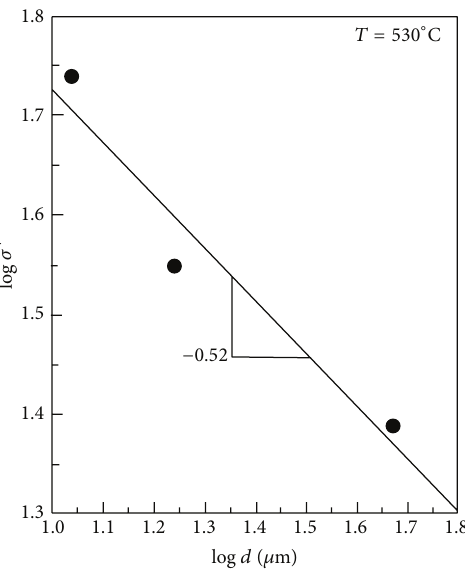
Figure 11: A Hall-Petch type relation between 𝜎 ∗ and d derived at 530 ∘